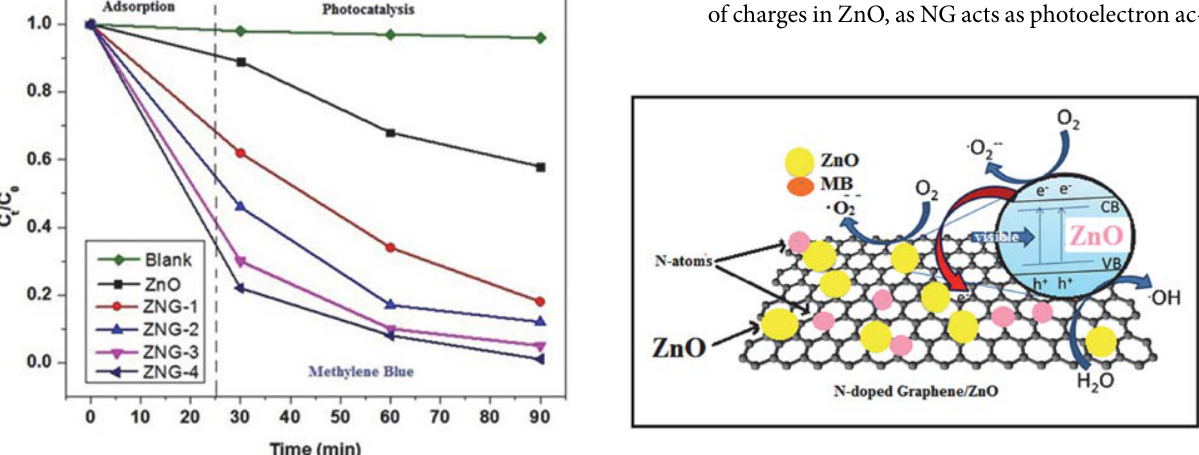
Figure 9. Proposed mechanism of photodegradation process MB